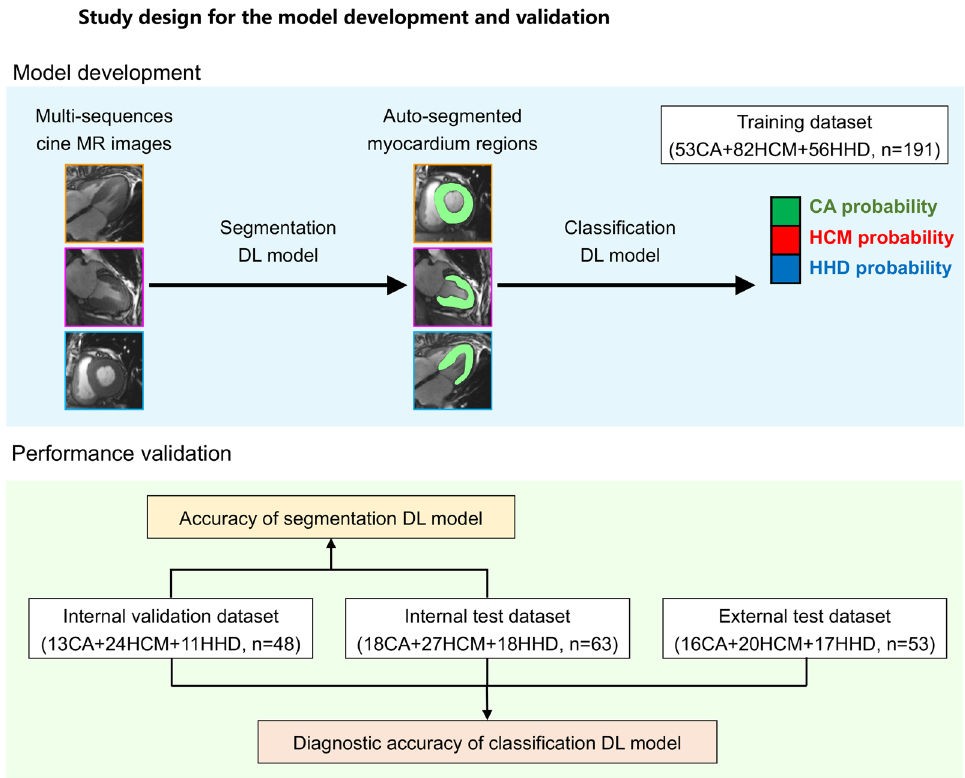
Fig. 1 Patient enrollment and study design. HCM—hypertrophic cardiomyopathy, CA—cardiac amyloidosis, HHD—hypertensive heart disease, DL—deep